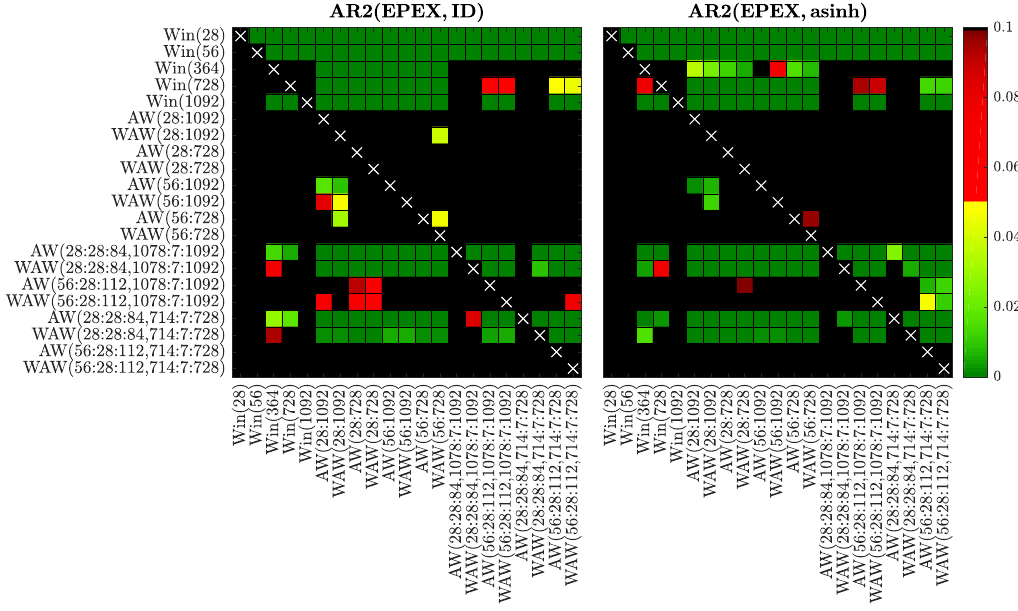
Figure 15. Results of the CPA test for selected window sets and the AR2 model fitted to raw ( left ) or asinh -transformed ( right ) EPEX prices. We use a heat map to indicate the range of the p -values—the closer they are to zero ( → dark green) the more significant is the difference between the forecasts of a set on the X -axis (better) and the forecasts of a set on the Y -axis (worse). Finally, the recommended above WAW (56:28:112, 714:7:728) averaging scheme performs strongly (see the largely green rightmost columns) and—in most cases—is not significantly outperformed